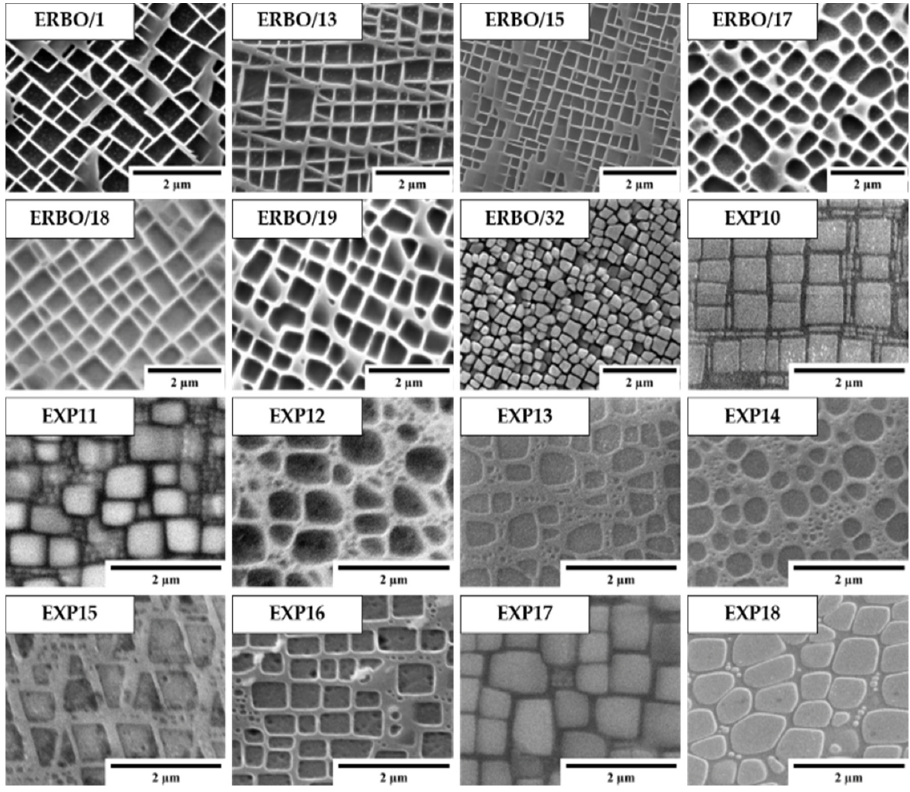
Figure 2. SEM micrographs of the γ / γ′ microstructure of all alloys in the homogenized and aged state.